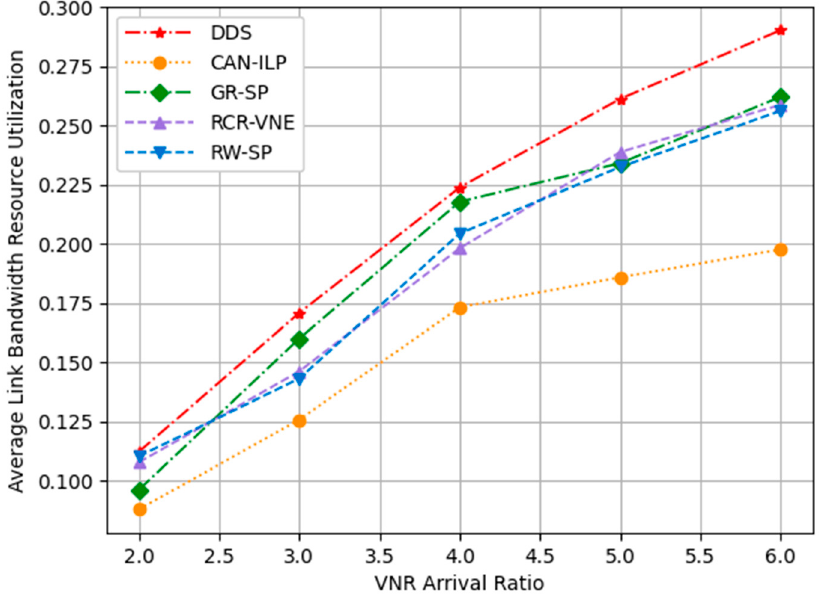
Figure 9. Average link bandwidth resource utilization under various VNR arrival ratios.